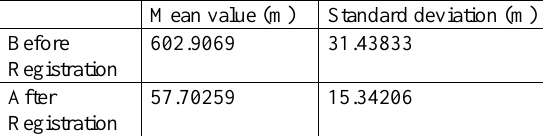
Table 1. Average offsets and standard deviations before and after registration